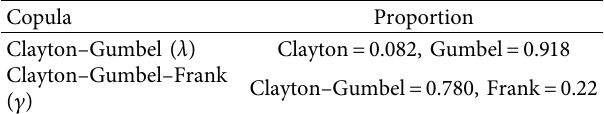
Table 4: Estimates of proportion.